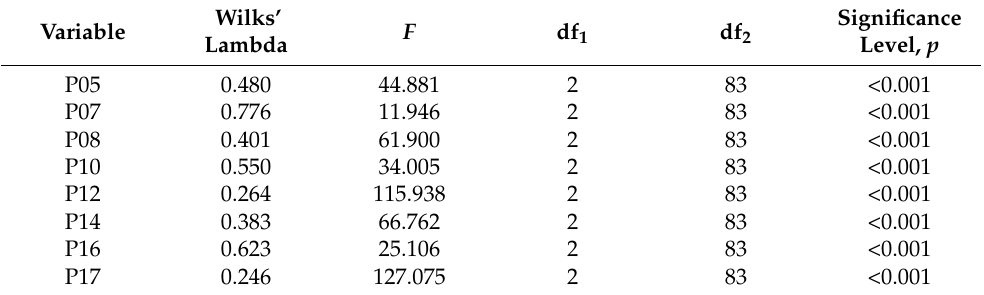
Table 2. Tests of equality of group means.